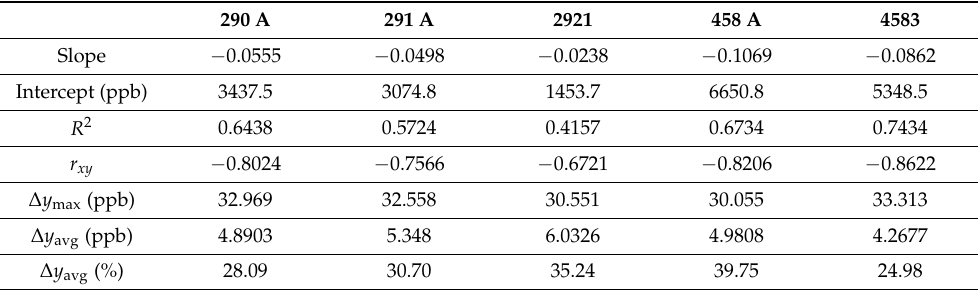
Table 7. Calculated values for data analysis of NO 2